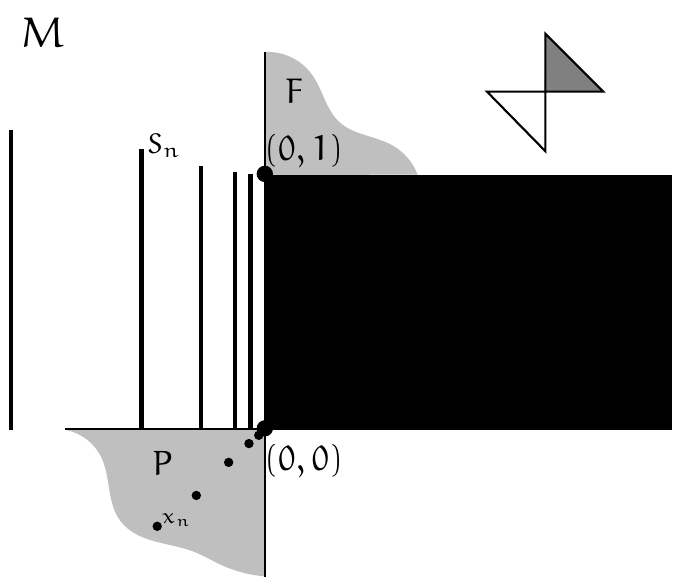
Figure 2 . M is constructed by removing from L 2 the black square and the vertical segments S n . As it was pointed out in [5, (cid:12)gure 11], the terminal sets P and F are S -related, and so, they form